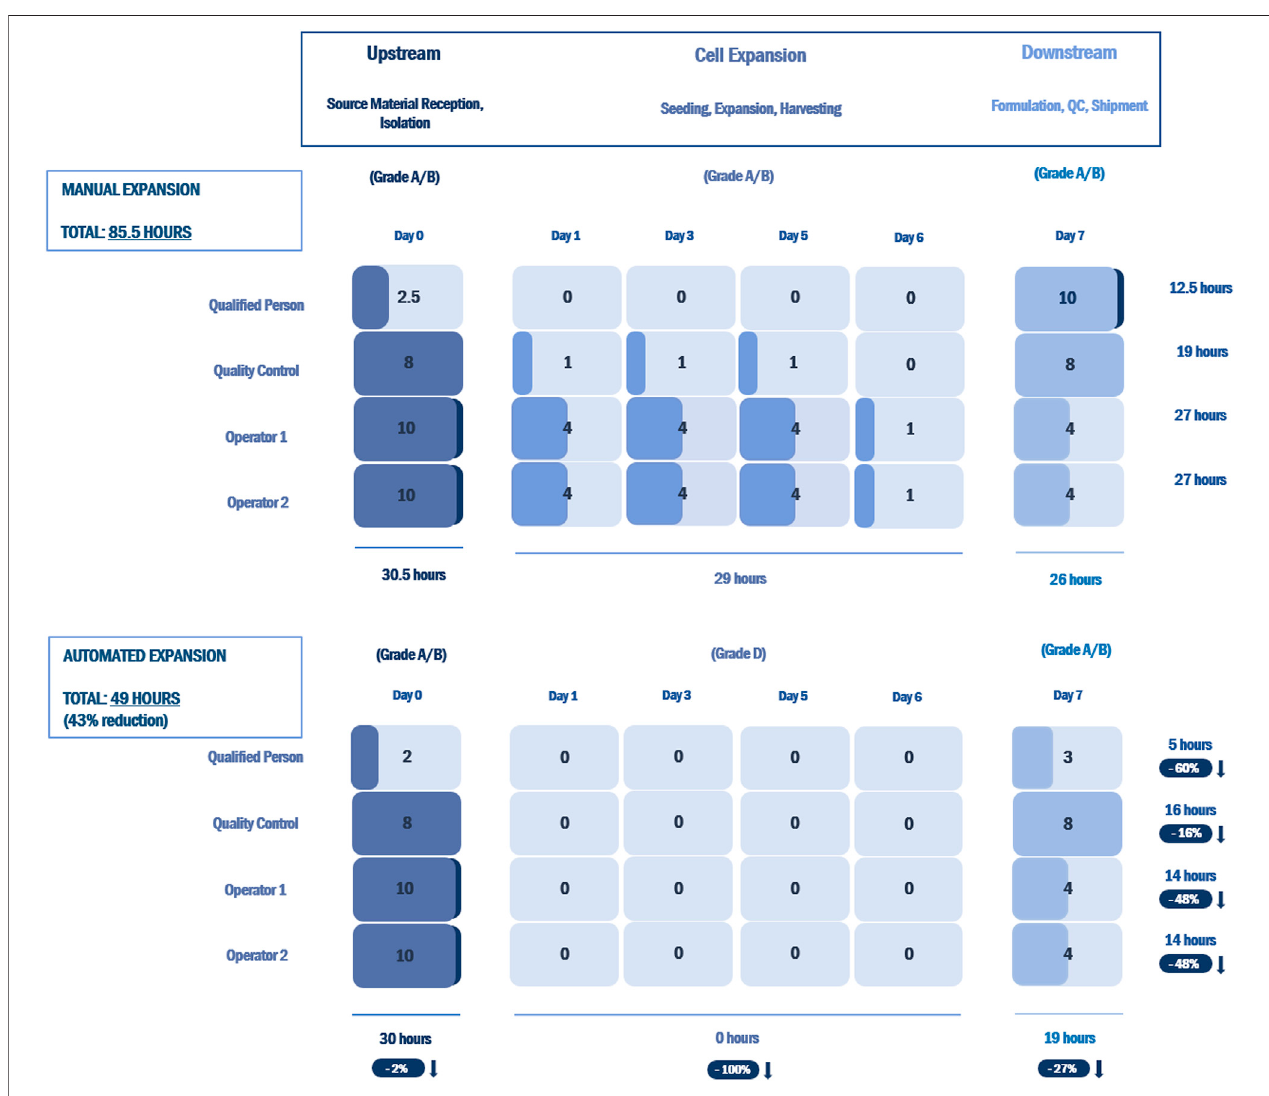
FIGURE6| Laborcommitmentanalysiscomparinganopen,manualexpansionprocess withanautomated expansionprocessusingtheNANT 001systemforan autologous therapy with a production process of 7 ± 1 days. Results are presented as hours of labor required per batch by a production team consisting of two manufacturingtechnicians, oneQCtechnician and oneQuali fi edPersonforallupstream,downstream andexpansionprocesses. Thepercentage reductionsinhoursof labor for the automated expansion process vs. the manual process are indicated.